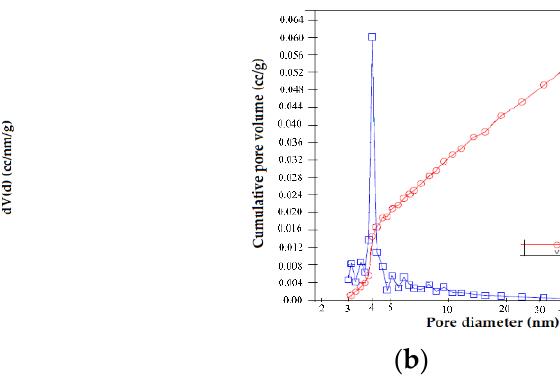
Figure 3. Pore size distribution curves of BN ( a ) and BN-Ag 0 ( b ).